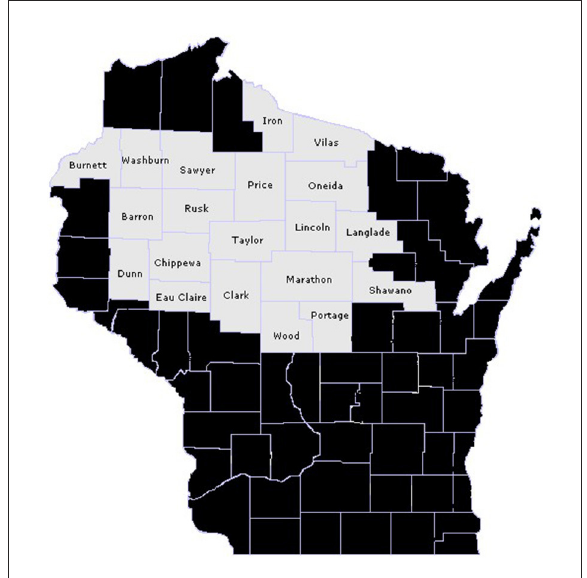
FIGURE1 20-county target population of north-central Wisconsin children and adolescents who did and did not live on a farm in